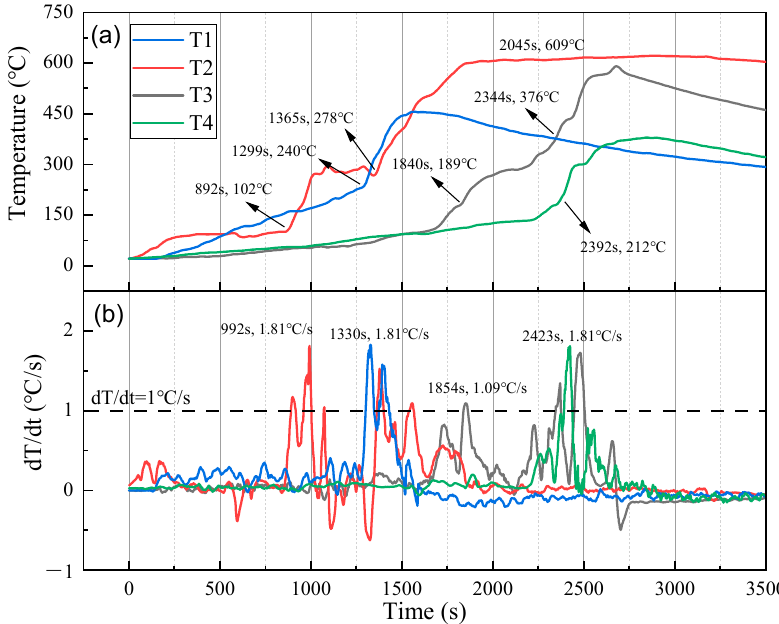
Figure 6. ( a ) Temperature and ( b ) dT/dt responses of LIB pack. As shown in Figure 7, the propane flame temperature at the bottom of the LIB pack was approximately 790 °C, which triggered the TR of the LIB pack. The maximum flame temperature of the LIB pack under the TR process was 939.7 °C, which was close to that reported during the TR of an LFP battery [20]. The temperatures of T6 and T7 were earlier signals reflecting the characteristics of TR or flame of the LIB pack than the temperatures of T1–T4. T6 and T7 were located above the middle of the LIB pack, and the safety valve rupture time and TR time of the batteries in the middle of the LIB pack were earlier than those of other batteries. Due to the LIB pack’s poor heat dissipation capability and uneven thermocouple distribution, it was not easy to transfer heat to the T1–T4 thermocouples. Therefore, T6 and T7 would be the first to receive temperature signals. After 1578 s, the